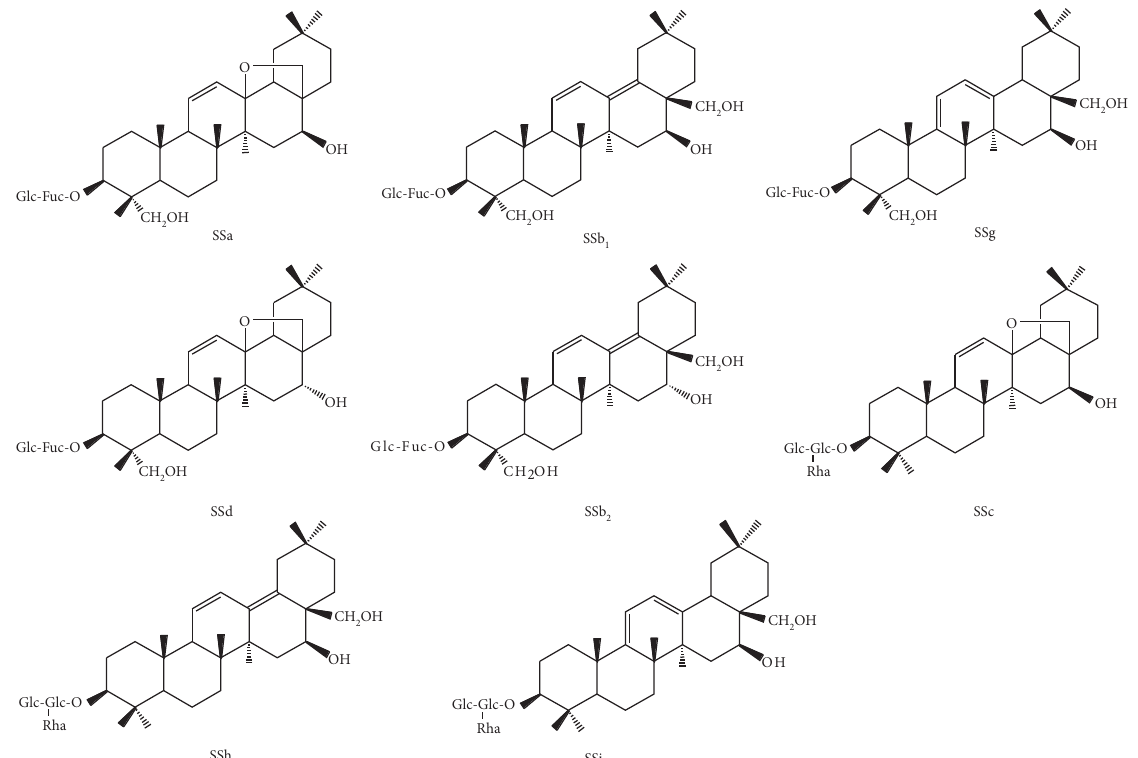
Figure 1: Structures of eight saikosaponins (Glc: β -D-glucose; Fuc: L-fucose; Rha: α